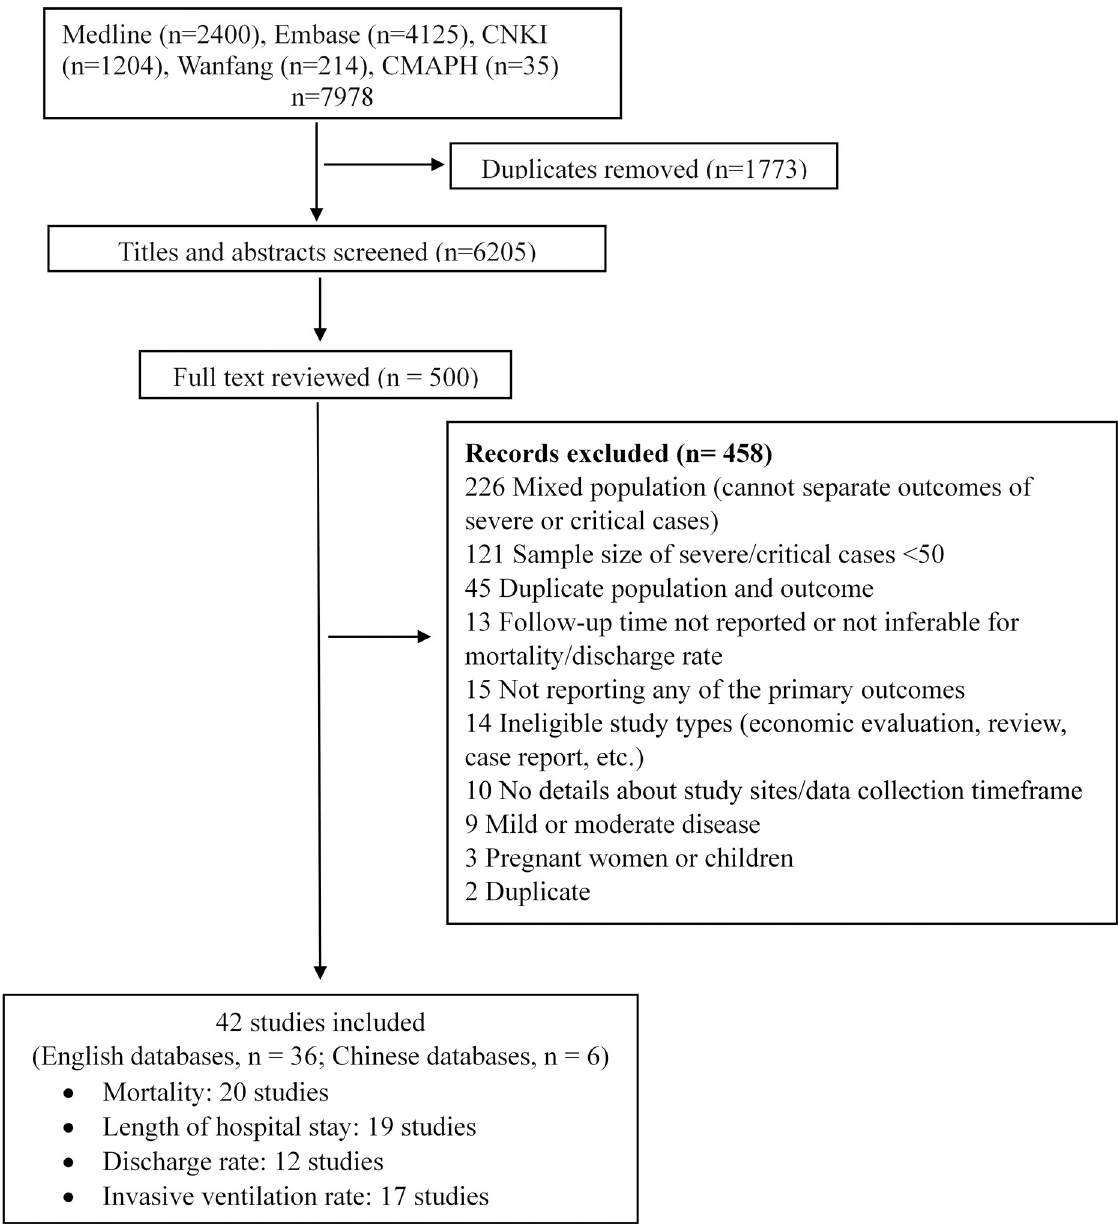
Fig 1. Flow diagram of literature screening and selection. disease severity following the Chinese guidelines for diagnosis and treatment of COVID-19 released by the National Health Commission. The mean age of patients ranged from 52.5 to 70.7 years. The proportion of males ranged from 44.9% to 68.5%. The numbers of studies included in the meta-analysis were 20 for CFR, 19 for LOS, 12 for the discharge rate and 17 for the rate of using invasive ventilation (Fig 1 & S2 Appendix). Thirty-seven studies reported the comorbidities of patients (S3 Appendix). The risk of bias of included studies was low (S4 Appendix). The results for heterogeneity and the publication bias analyses are presented in S5 Appendix.